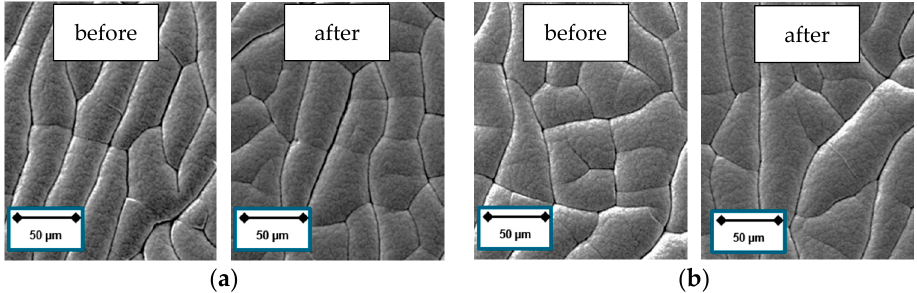
Figure 9. Surface condition: ( a ) Coated 1.5 phr substrate before and after initial approach with 10 N; ( b ) coated 9 phr substrate before and after initial approach with 10 N.